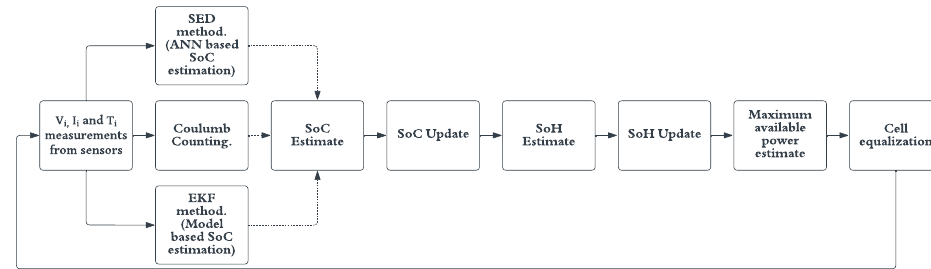
Figure 1. General BMS task flow.